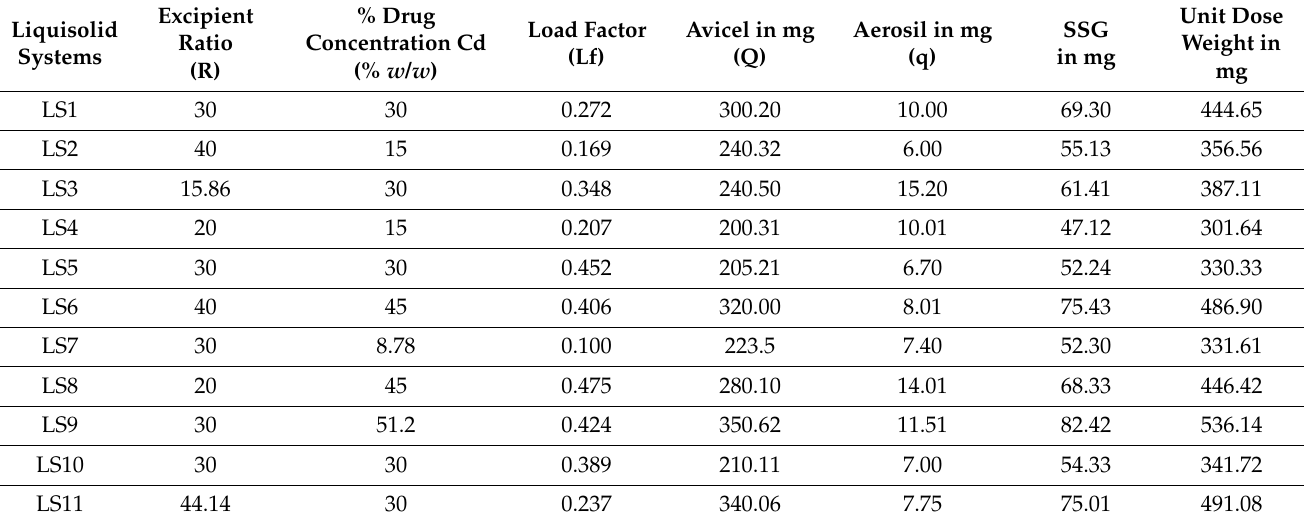
Table 2. Compositions of different liquisolid compacts of mirtazapine according to the mathematical model and